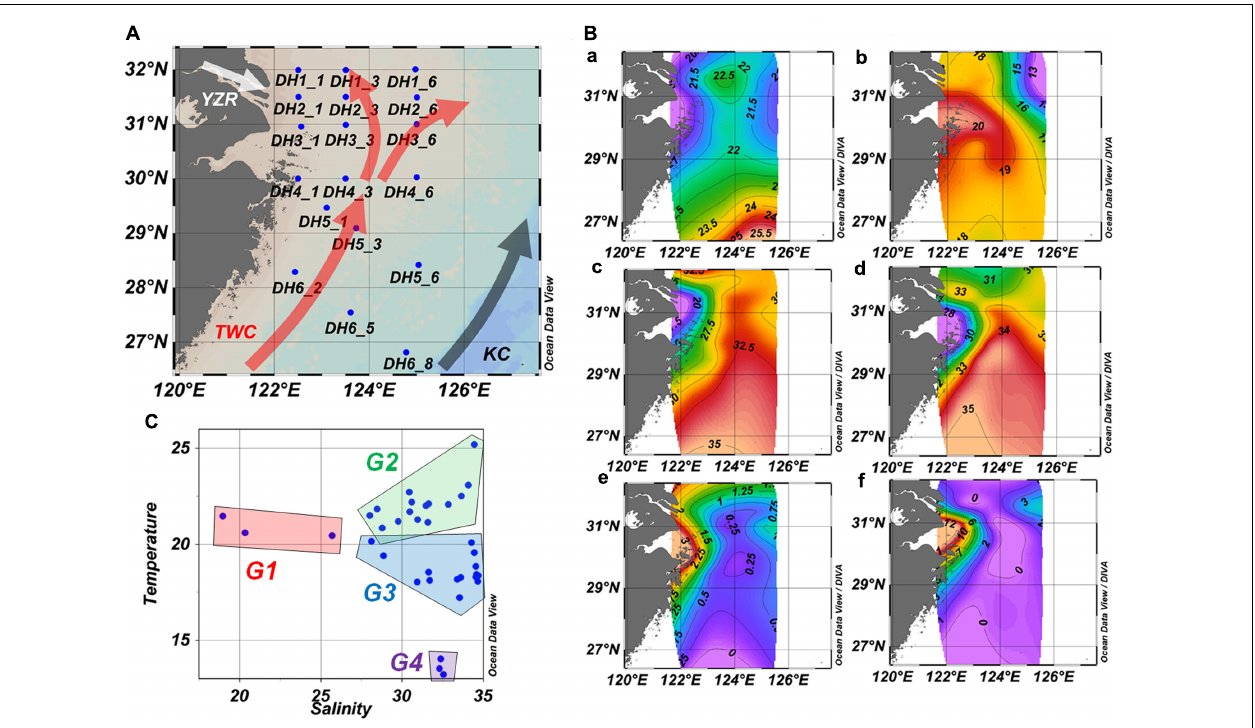
FIGURE 1 | Sampling station (A) , environmental parameter distribution (B) , and temperature–salinity relationship (C) in the ECS. (B) Temperature ( ◦ C, a,b), salinity (c,d), and Chl a concentration ( µ g/L, e,f) of surface water samples (a, c, e) and bottom water samples (b, d, f). TWC, Taiwan warm current; KC, Kuroshio Current; YZR, Changjiang